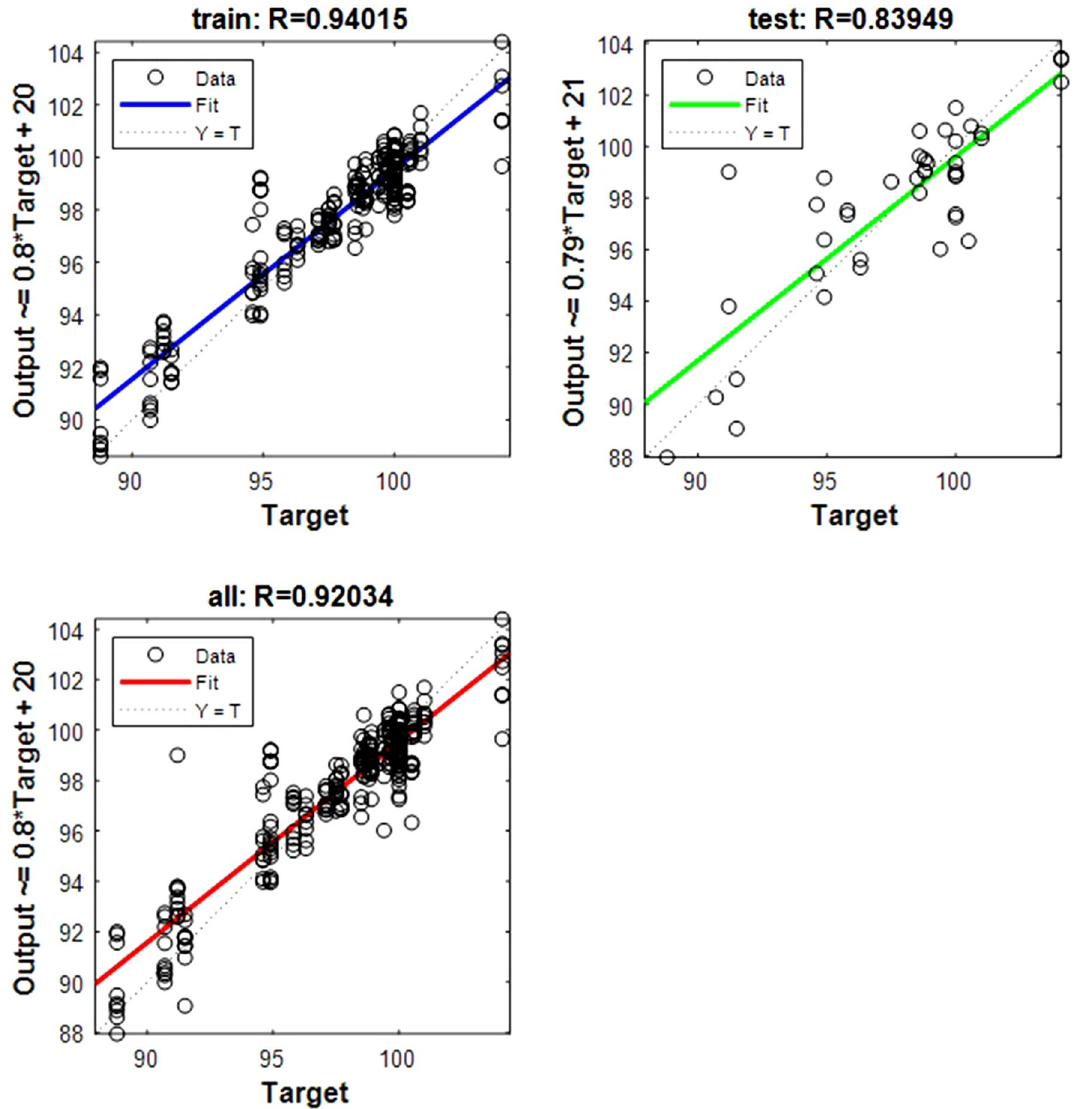
Figure 7. Shows the regression plot between the NIR-absorbance of spent dialysate and the MCV concentration in the patient blood at the beginning of the hemodialysis session (wavelength from 700–1700 nm, R all = 0.92, R train = 0.94, R test = 0.83, number of spectra used for training was N = 270). The MCV concentration in patients’ blood was 97.446 ± 6.46 (mean ± SD). The equation relating the predicted and measured values is Output = 0.8*Target +